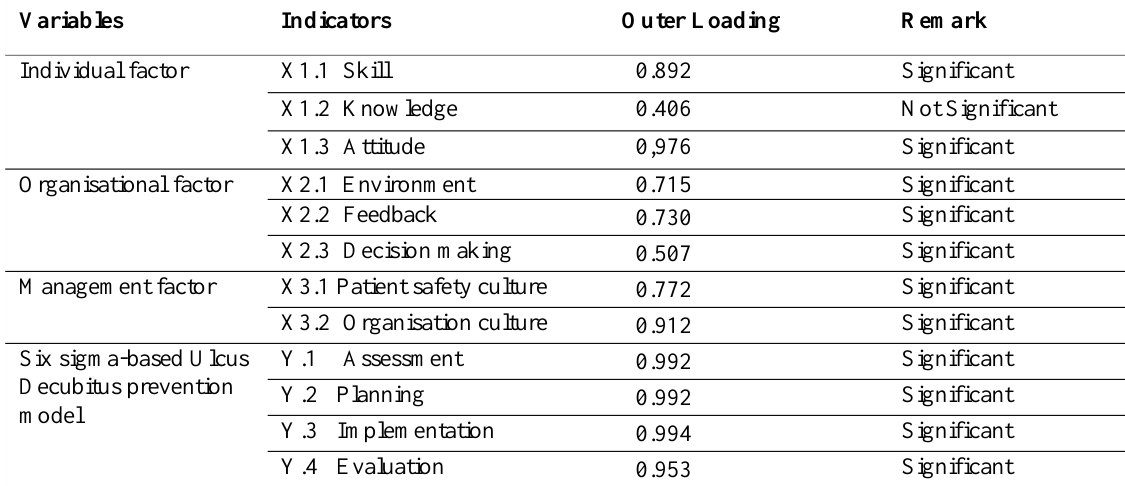
Table 3. Recapitulation of the results of the hypothesis test of the development of a prevention model for Six Sigma based ulcers and Unexpected Events (KTD) in the Inpatient Room Variables